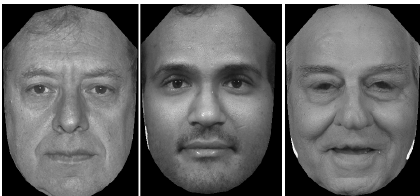
Figure 3. A sample of images from FERET dataset with face alignment.